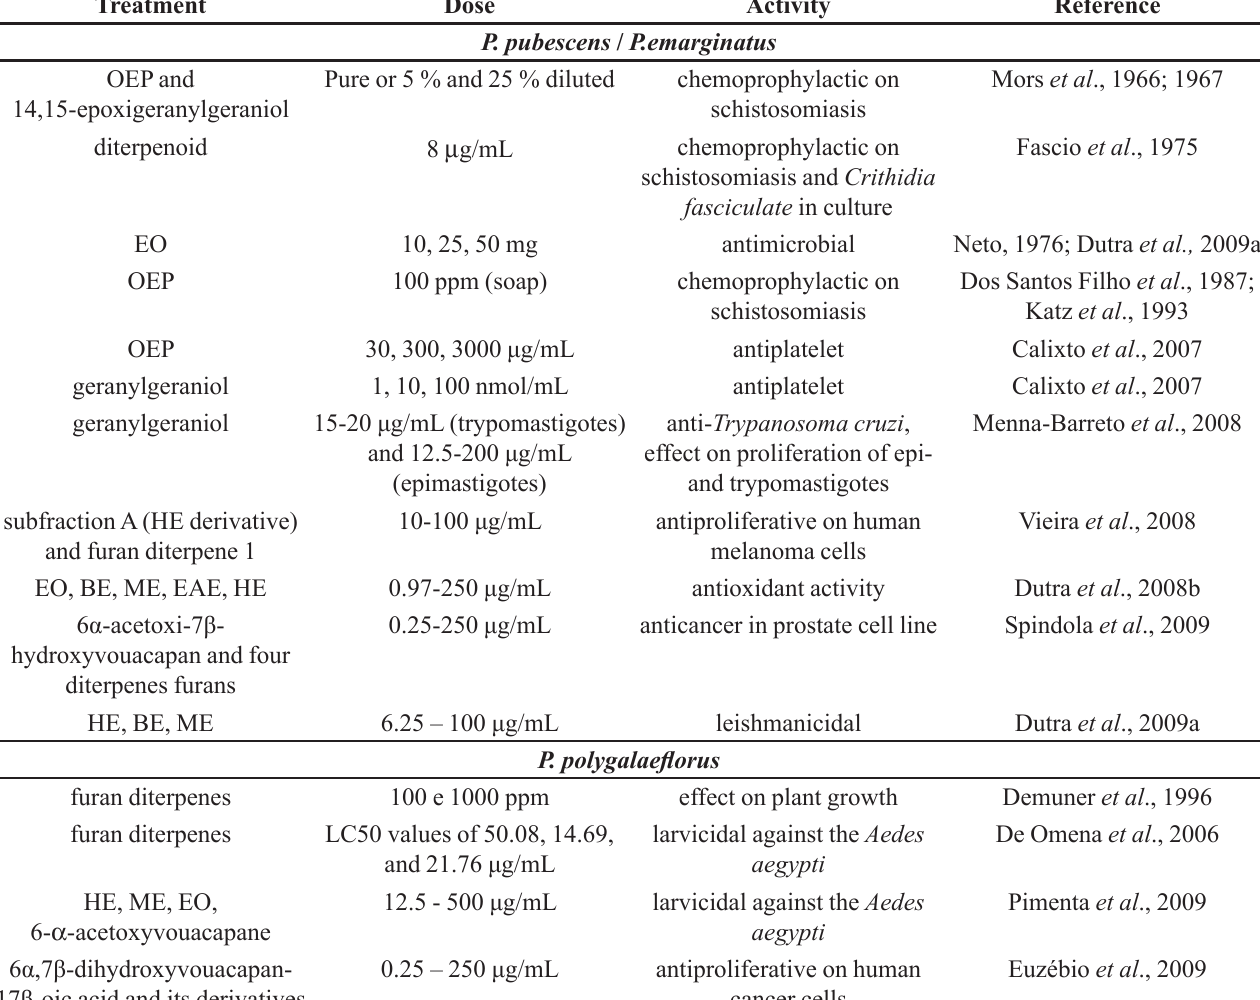
TABLE II - Biological activities in vitro of Pterodon spp . plant extracts/vouacapan